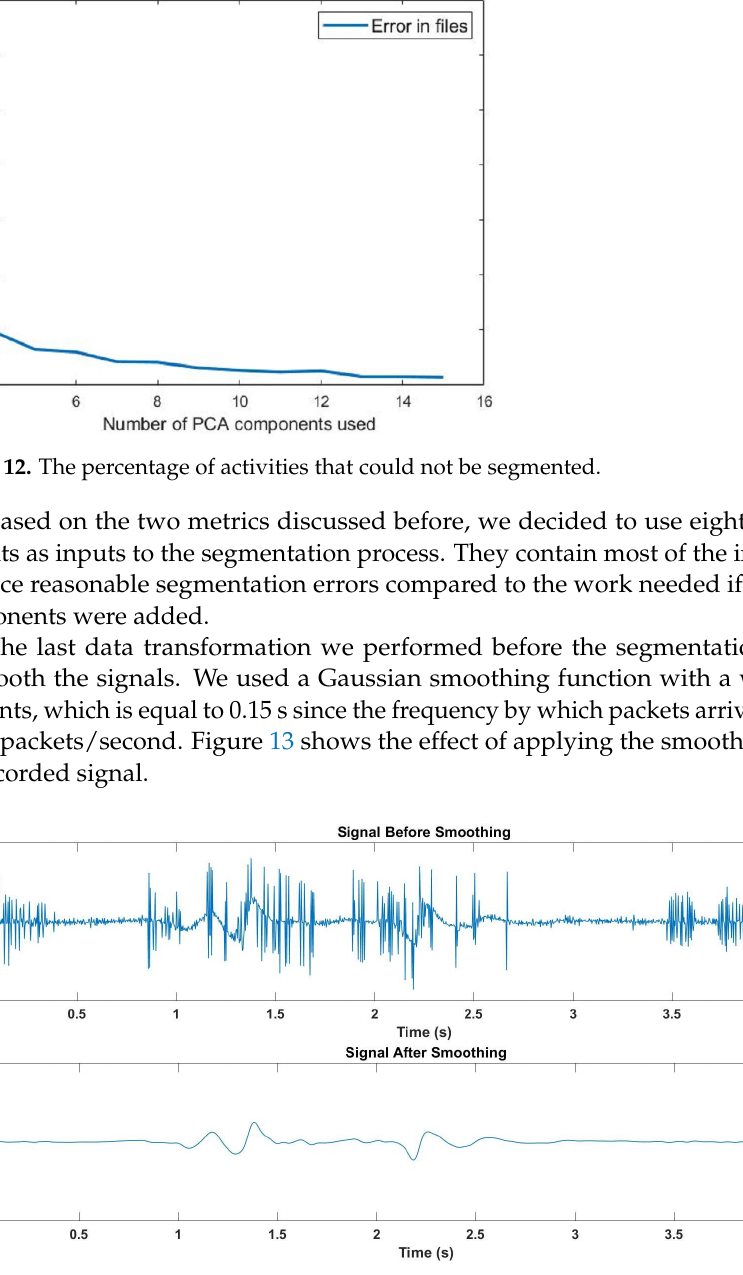
Figure 13. Effect of applying the smoothing technique on a recorded